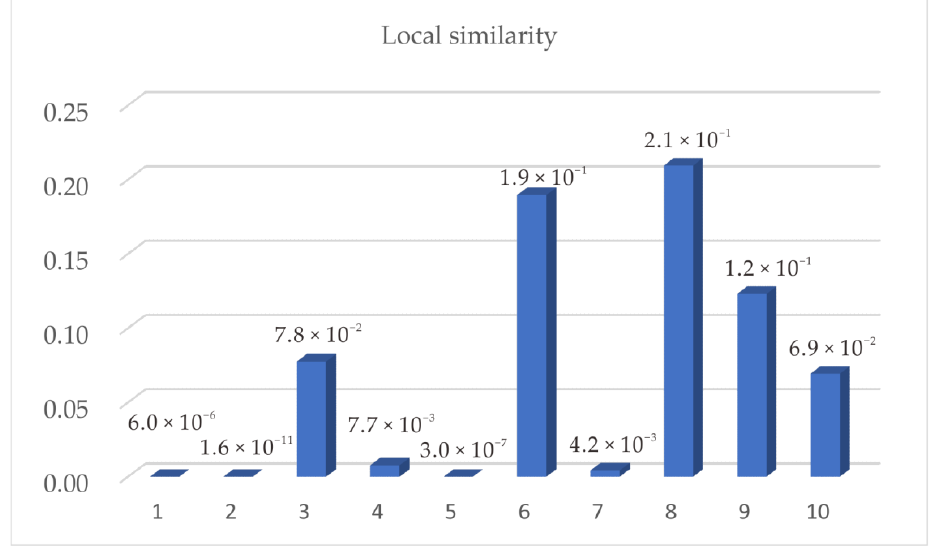
Figure 3. Local similarity of the picked peaks.